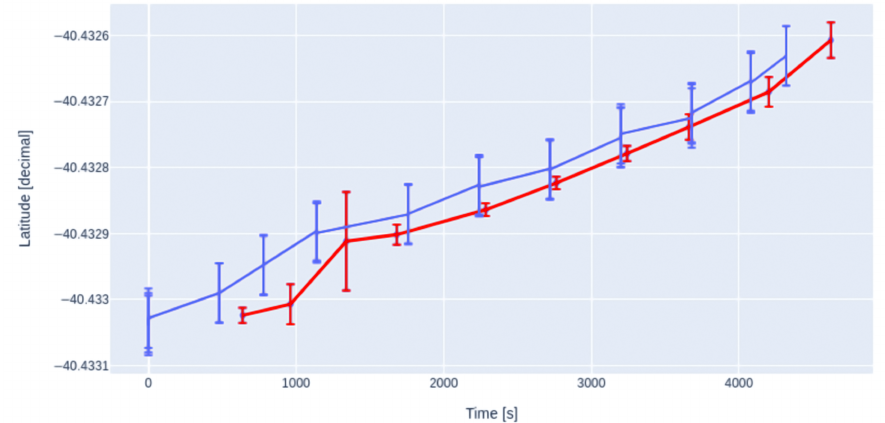
Figure 6. Latitude measured with a handheld Garmin GPS (blue) overlapped with the same positions measured with the MD (red), at the same positions plotted in Figure 5. The error bars represent the measurement errors as explained in the text for each